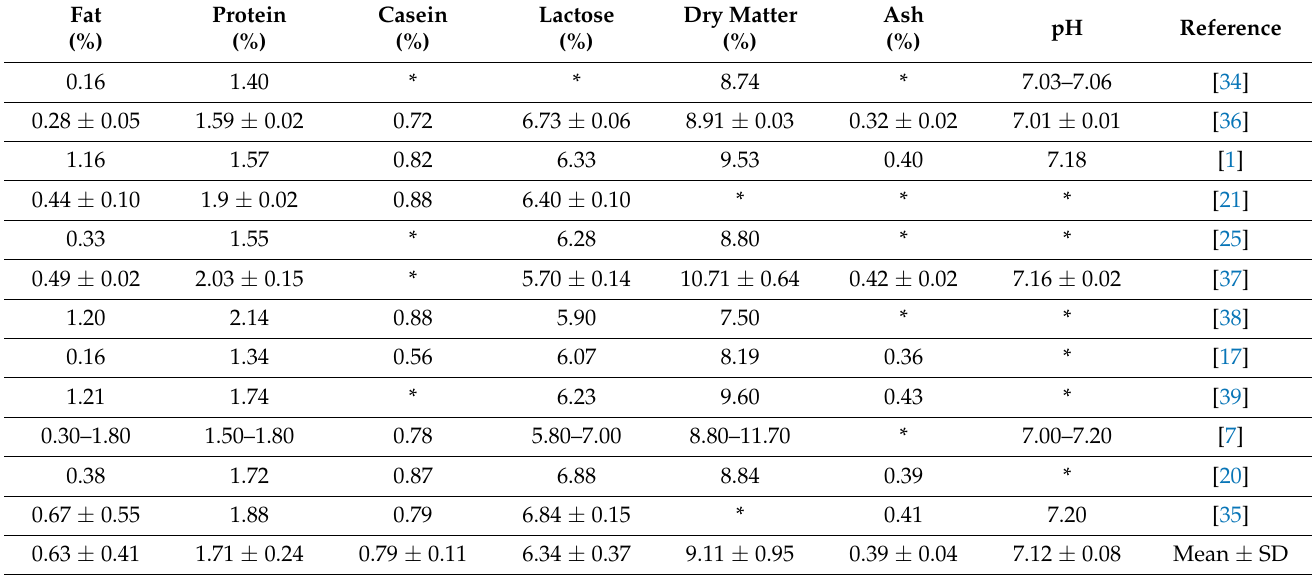
Table 2. Physicochemical composition parameters of donkey